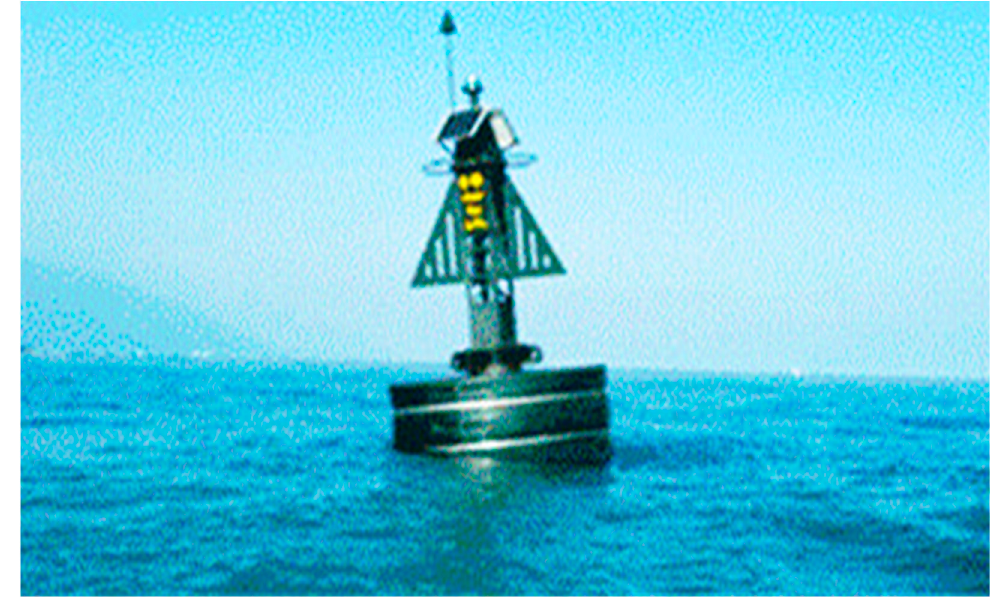
Figure 2. View of Nowshahr buoy (36°42 ′ 09 ″ N, 51°37 ′ 17 ″ E). Courtesy of Ports and Maritime Organization Iran (PMO).